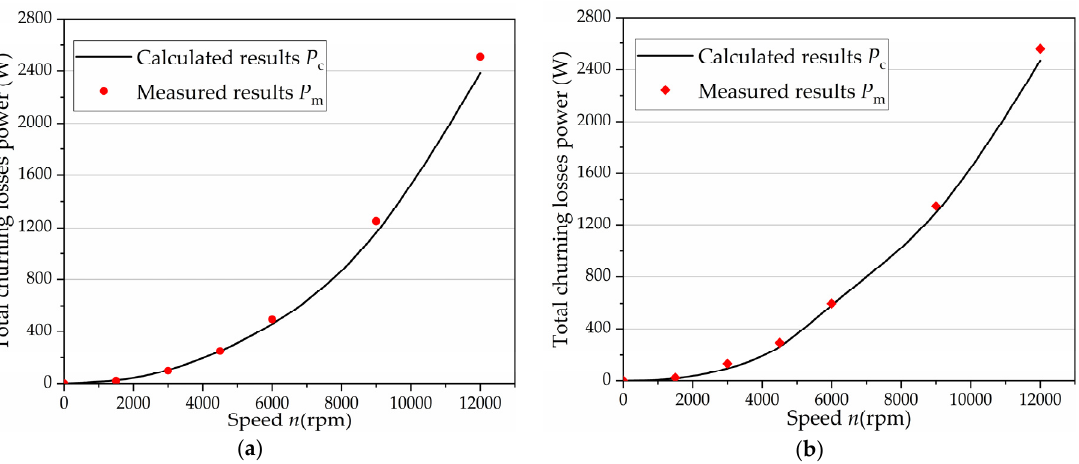
Figure 12. Comparisons between the experimental and calculated results of total churning losses: ( a ) tested churning losses power of nine pistons at different speeds; and ( b ) tested churning losses power of six pistons at different